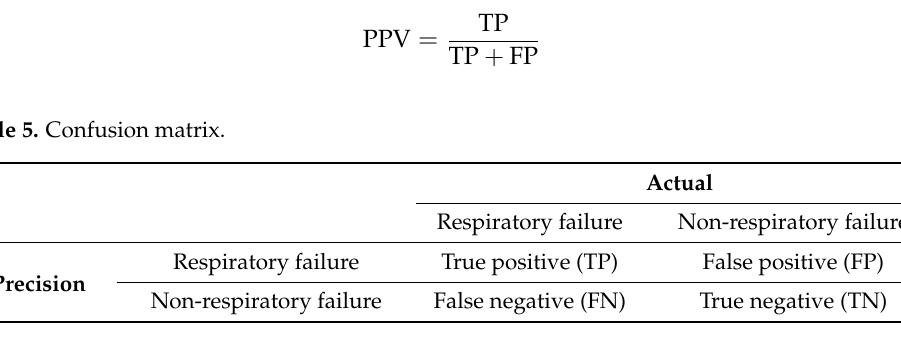
Figure 16. Stratified k-fold processing (in this case, k is 4).